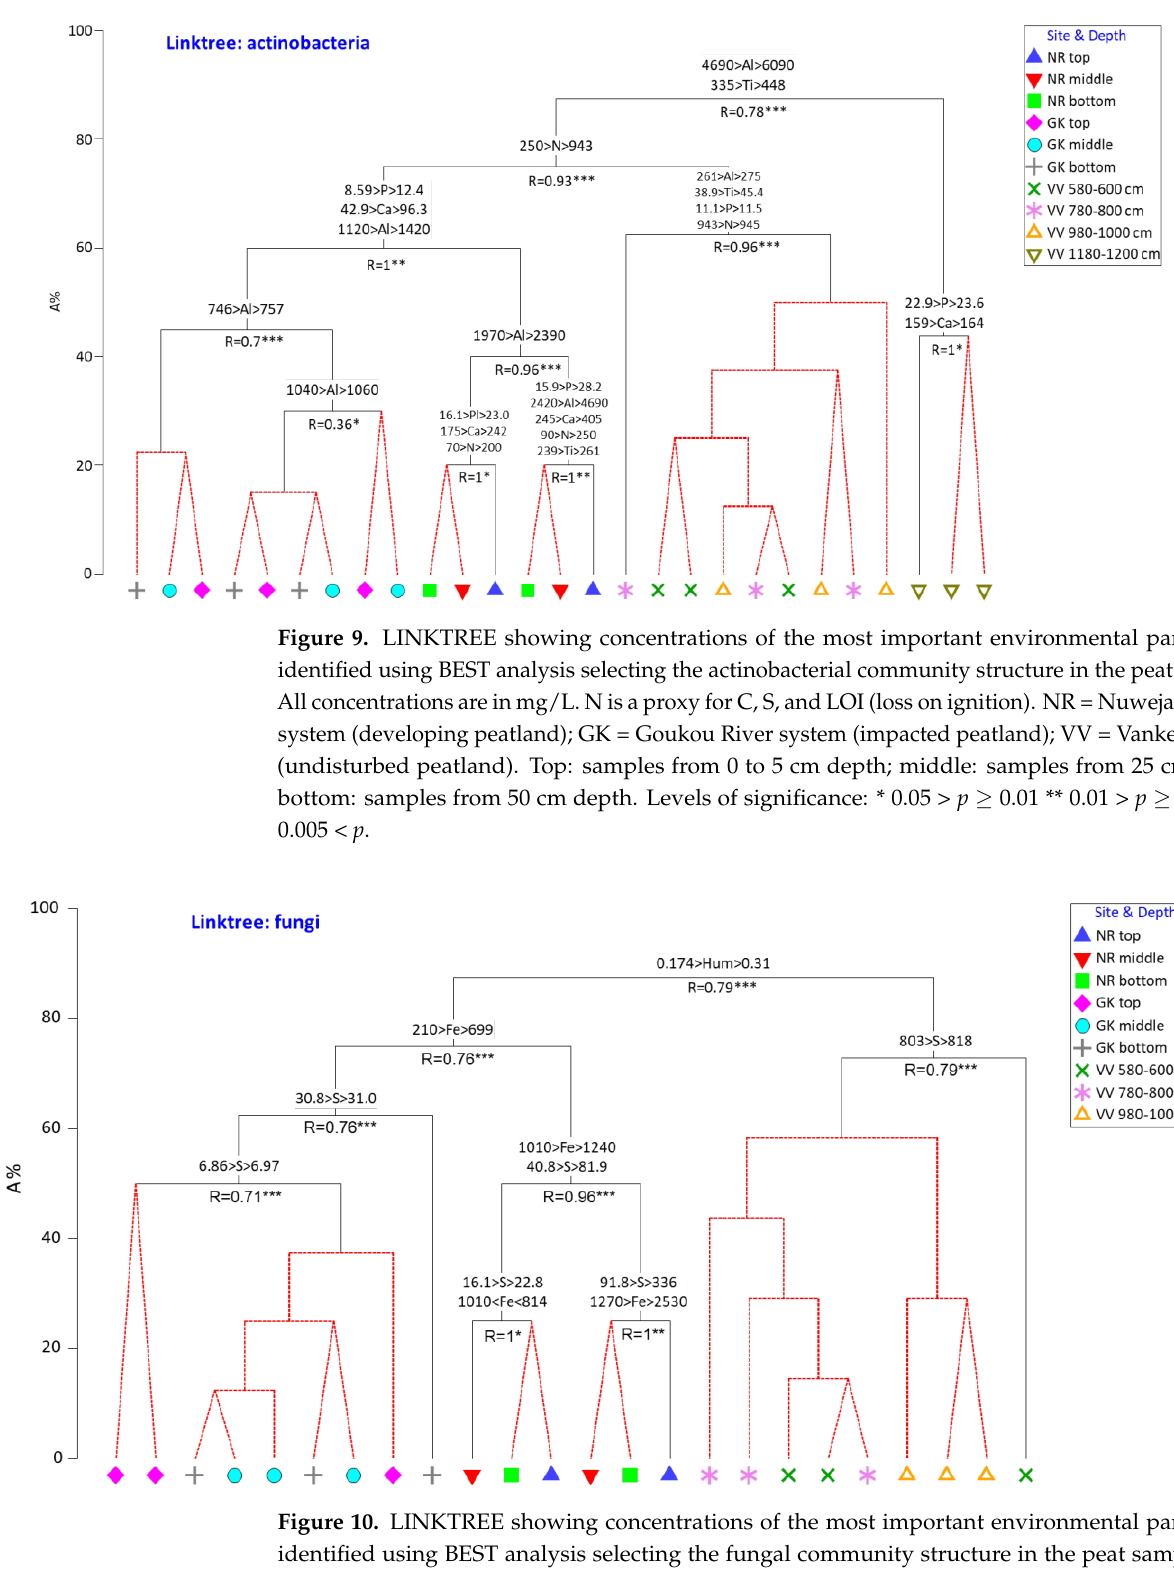
Figure 10. LINKTREE showing concentrations of the most important environmental parameters identified using BEST analysis selecting the fungal community structure in the peat samples. All concentrations are in mg/L except humification (Hum). S is a proxy for N, C, and LOI (loss on ignition). NR = Nuwejaars River system (developing peatland); GK = Goukou River system (impacted peatland); VV = Vankervelsvlei (undisturbed peatland). Top: samples from 0 to 5 cm depth; middle: samples from 25 cm depth; bottom: samples from 50 cm depth. Levels of significance: * 0.05 > p ≥ 0.01 ** 0.01 > p ≥ 0.005 *** 0.005 < p